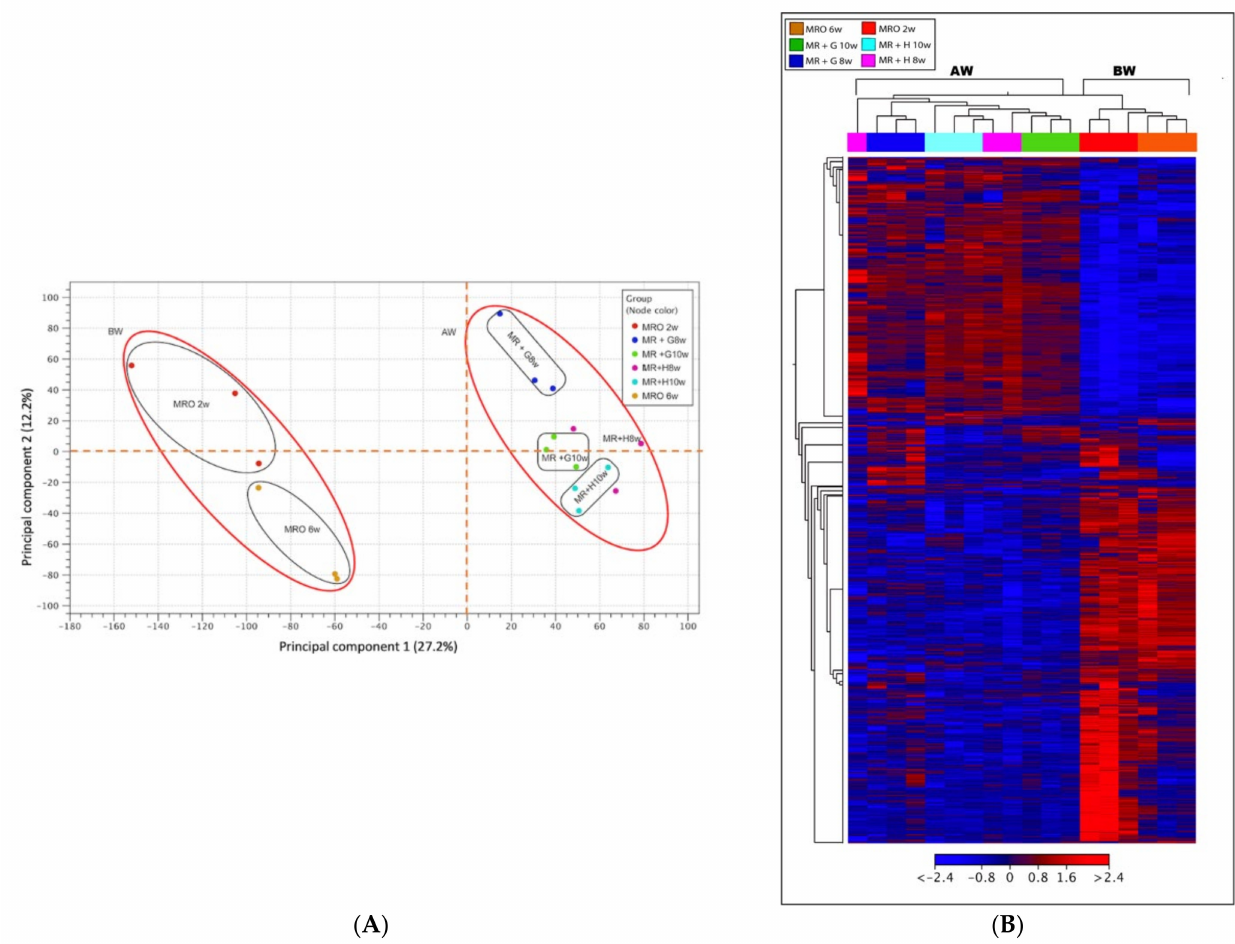
Figure 2. Gene expression dynamics are weaning state-specific. ( A ) PCA comparing gene expression patterns of the 6 groups defined in Figure 1. Each dot denotes a single biological replicate, and the ellipses represent the groups. The PCA (PERMANOVA tests) distinguishes temporal patterns where the transcriptomes cluster separately between groups pre- and post-weaning. ( B ) The hierarchical heatmap (Euclidean distance) of selected DEGs of all 6 groups. The heatmap shows the average linkage and shift of DEGs between BW and AW groups, and the consistency within the pre-weaning and post-weaning groups. The rows of the matrix are individual genes, and the columns correspond to each sample. The heat map is scaled with red and blue colors proportionate to gene expression value (red represents up-regulated and blue represents down-regulated, color range: log 2 fold change). AW: after weaning; BW: before